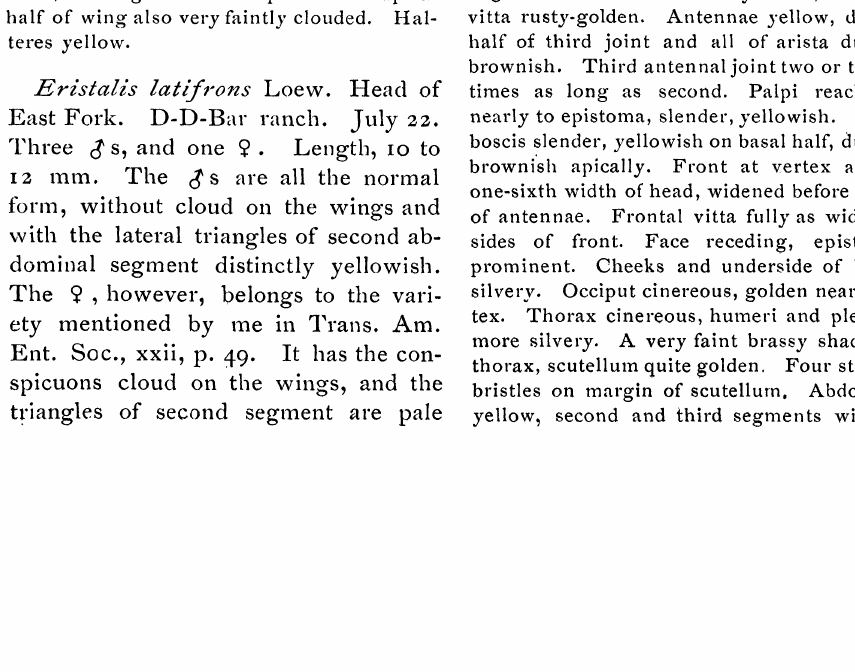
fourth and fifth segments each with four of these sub-square black markings united along front border, sixth segment wholly black. Abdomen thinly yellow-hairy. Legs yellow, the hips, knees, ends of tibiae, and whole of tarsi black, except middle and hind metatarsi and next tarsal joint which are yellow, only the distal ends being black. Wings with the first basal cell more than half clouded prox- imally, the second basal cell less than half, the anal cell not at all except narrowly in dis- tal end, the two basal cells being also clouded in distal ends. The distal ends of the mar- ginal and first submarginal cells with an apical cloud, which extends into the second submarginal cell. The median broad black cross-band of wing invades slightly more than the proximal half of the first submar- ginal and first posterior cells, the whole of discal cell, less than proximal half of second posterior cell, about half of third posterior, all but the distal end of fourth posterior, and hardly the proximal half of fifth posterior, besides also the distal ends of the anal and basal cells as above mentioned. The clear portion of basal half of wing is whitish, ex- cept for the broad border of anal angle which is very faintly cloudy; likewise there is a white distal border to the middle transverse band, leaving the clearer portion of apical half of wing also very faintly clouded. Hal- teres